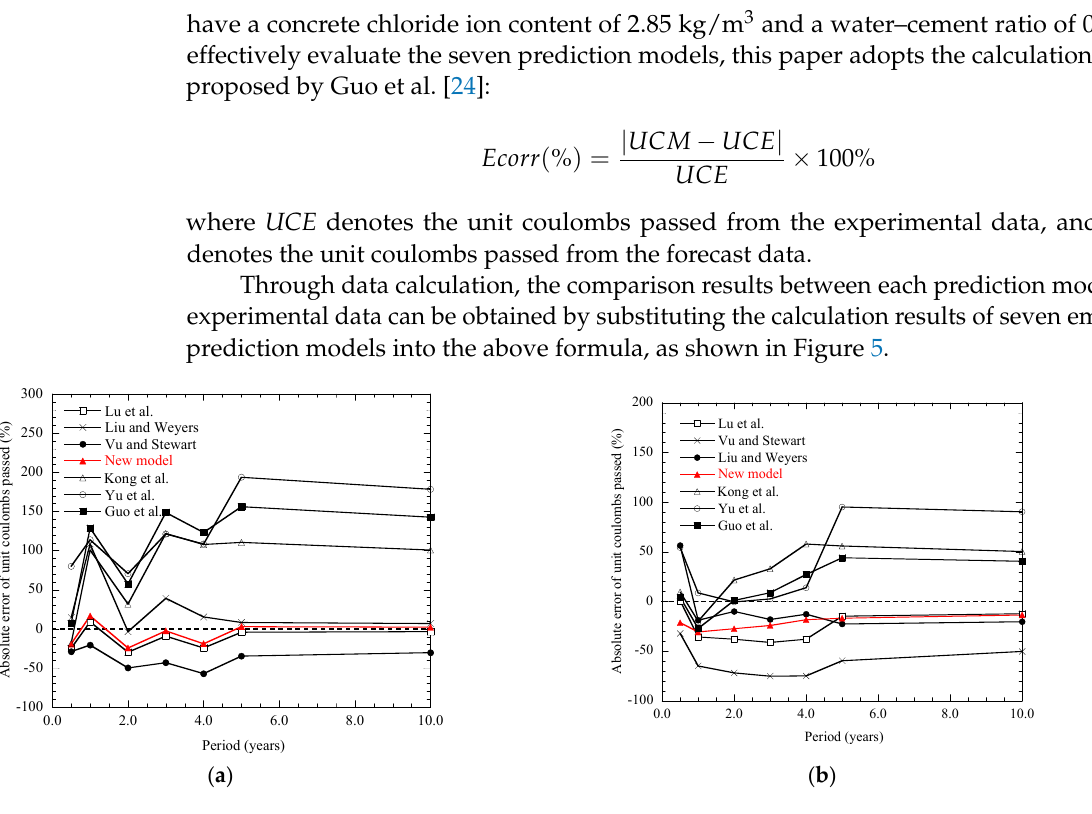
Figure 5. Comparison results between calculated values and experimental values. ( a ) The covering layer has a thickness of 50 mm. ( b ) The covering layer has a thickness of 70 mm [15,16,22 − 25].